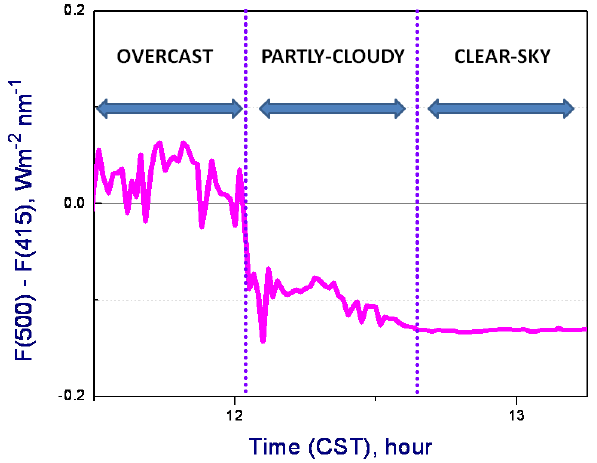
Fig. 5. Temporal realizations of the visible (red) and shortwave Fig. 5 . Temporal realizations of the visible (red) and shortwave (black) (black) fractional sky cover for 28 July 2007. Purple and cyan solid fractional sky cover for July 28, 2007. Purple and cyan solid circles represent circles represent the hourly-averaged ARSCL nadir-view cloud fraction for all and low clouds, the hourly-averaged ARSCL nadir-view cloud fraction for all and low clouds, respectively.